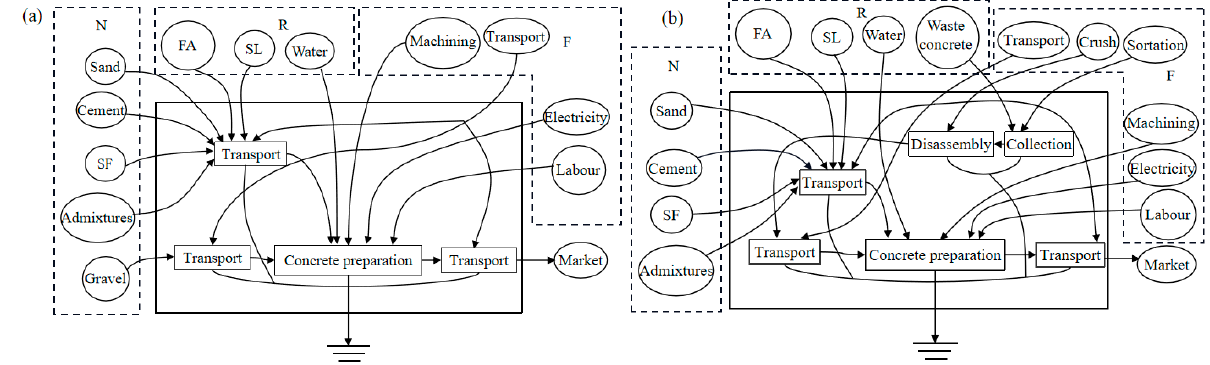
Figure 15. The flow mode of energy in concrete production is ( a ) NAC; ( b ) RAC. Table 5. Emergy evaluation form of